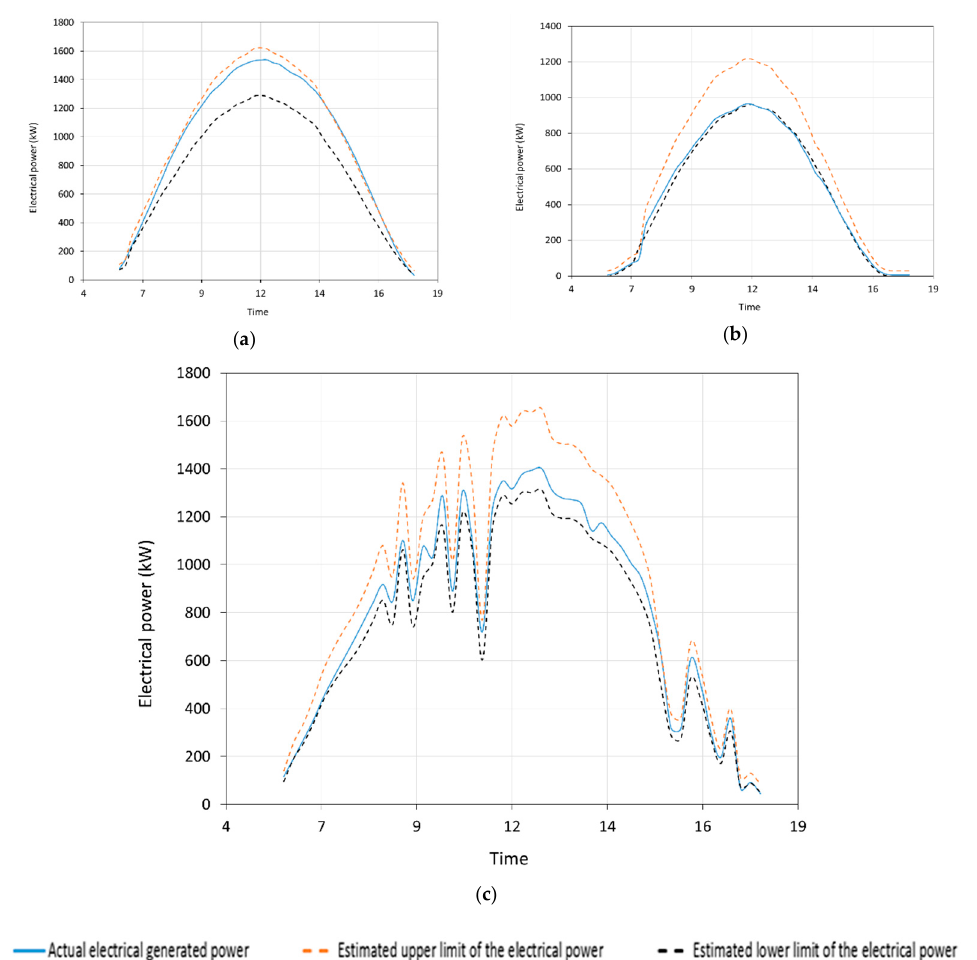
Figure 8. The daily actual electrical generation and the estimated upper and lower electrical generation on ( a ) 26 April 2019,